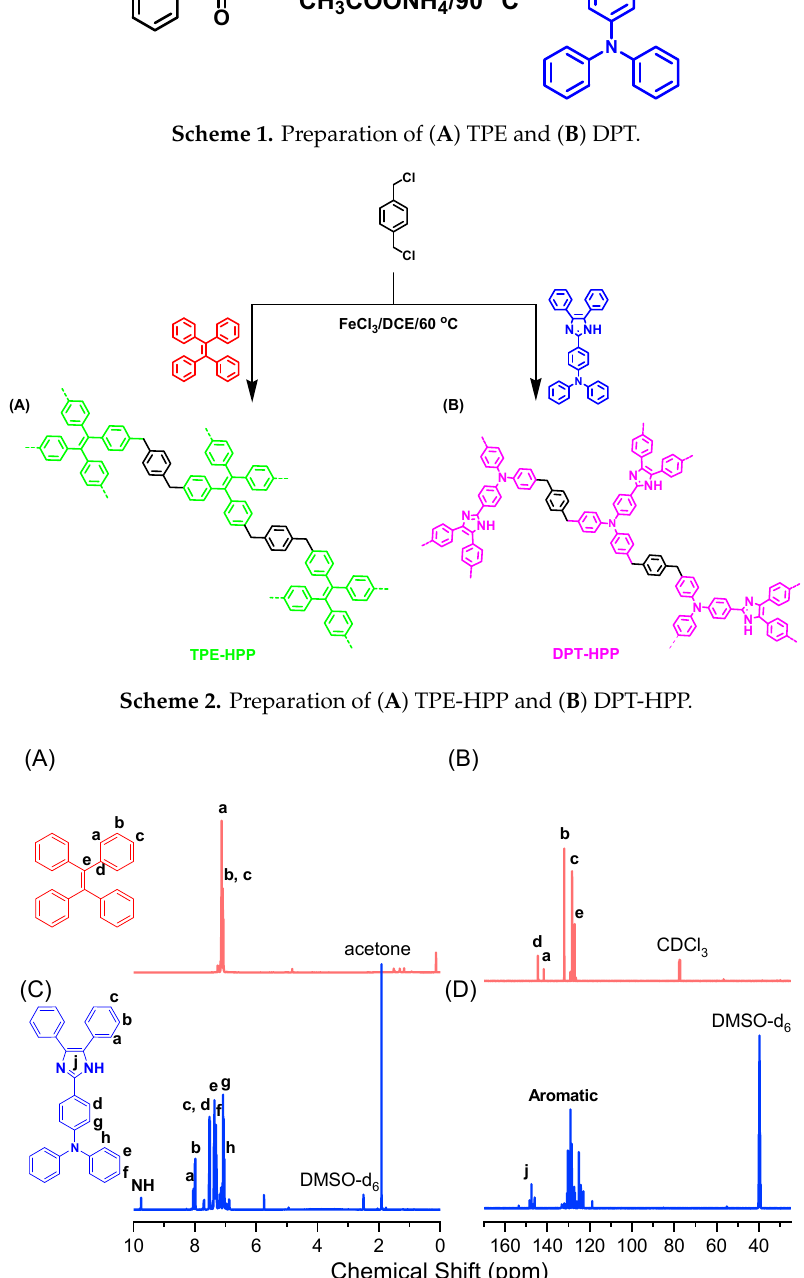
C=CC=C N-H Figure 2. FTIR analyses of ( A ) Ph-2Cl, ( B ) TPE, ( C ) DPT, ( D ) TPE-HPP and ( E ) DPT-HPP.